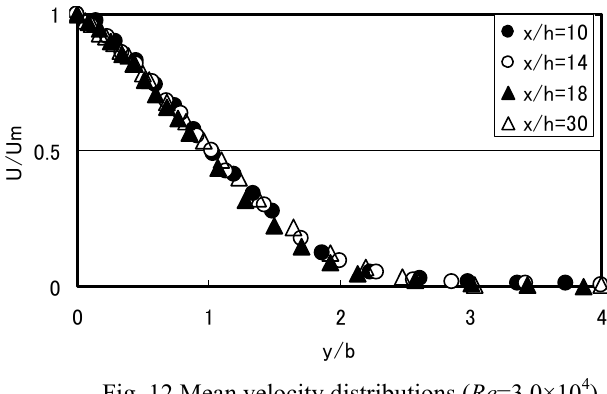
Fig. 12 Mean velocity distributions ( Re =3.0×10 4 ).